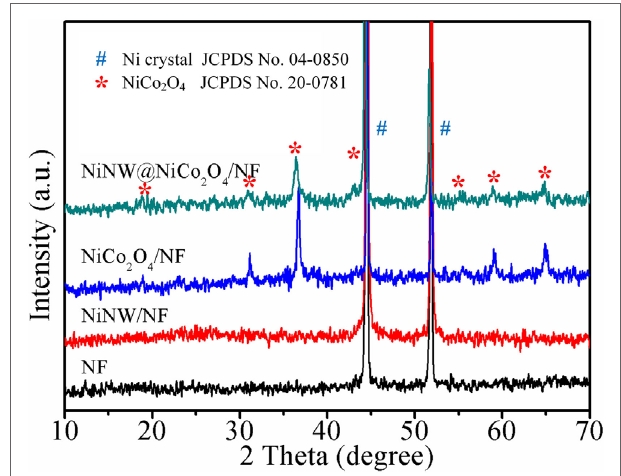
FigUre 1 | The X-ray diffraction (XRD) patterns of NF, Ni NW/NF, NiCo 2 O 4 / NF, and Ni NW@NiCo 2 O 4